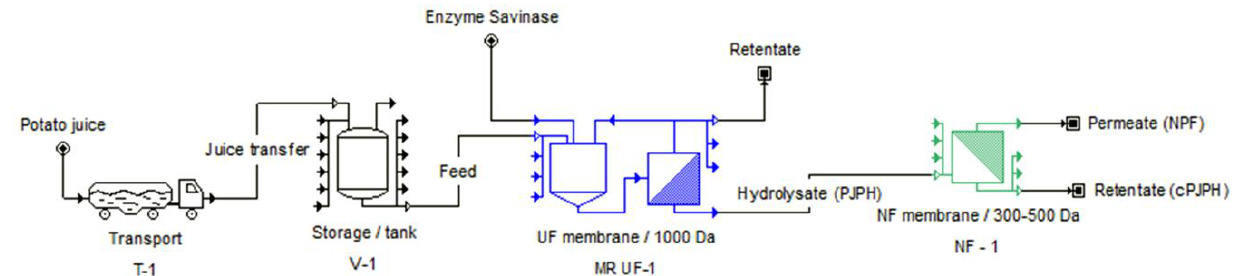
Figure 1. Schematic diagram of the applied membrane separation system for ultrafiltration.